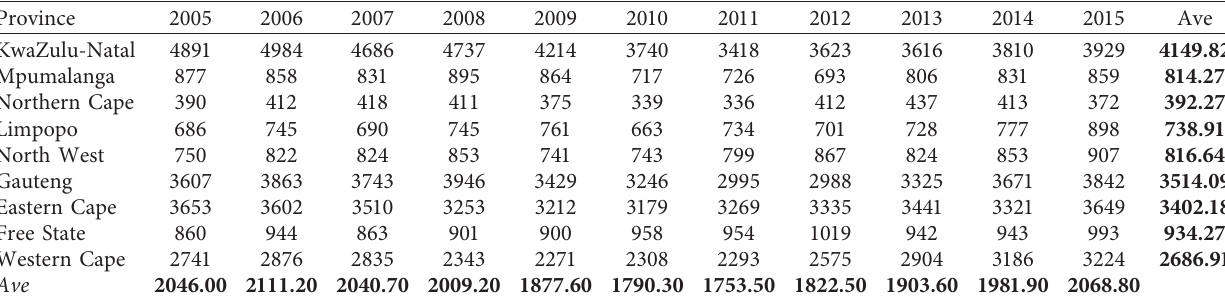
Table 1: Murder statistics in South Africa per province over a ten-year period.